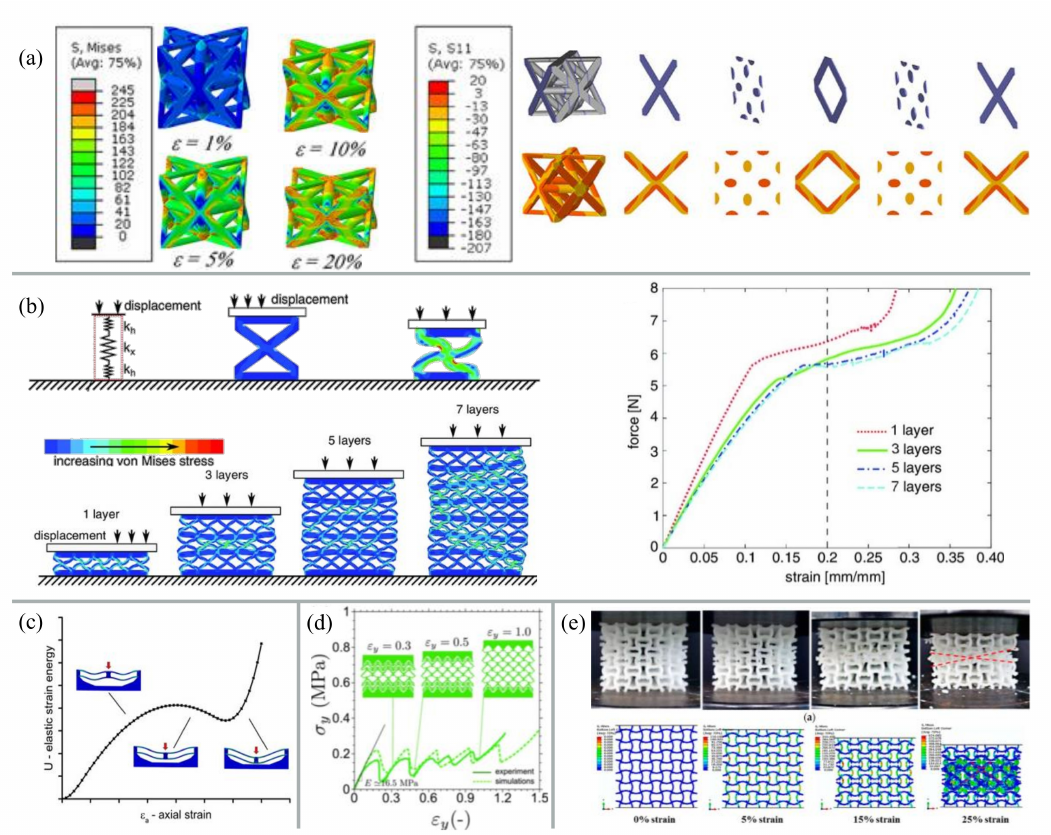
Figure 4. Examples of simulations as tool for topological and deformation optimization of metamaterial unit cells. ( a ) Simulation of Van Mises stresses in octet-truss unit cells under di ff erent strains (left) and stress distribution within the octet-truss at 1% strain (right) [78]; ( b ) Simulation of Van Mieses stress in unit cells showing deformation and collapse behavior [41]; ( c ) Simulation of elastic energy of a unit cell with bi-stable behavior under compression [2]; ( d ) Experiments and simulation of the stress-strain diagram of a sequentially snapping metamaterial [55]; ( e ) Experiment and simulation of a metamaterial under compression [79]. Figures are reproduced and adapted with permission from John Wiley